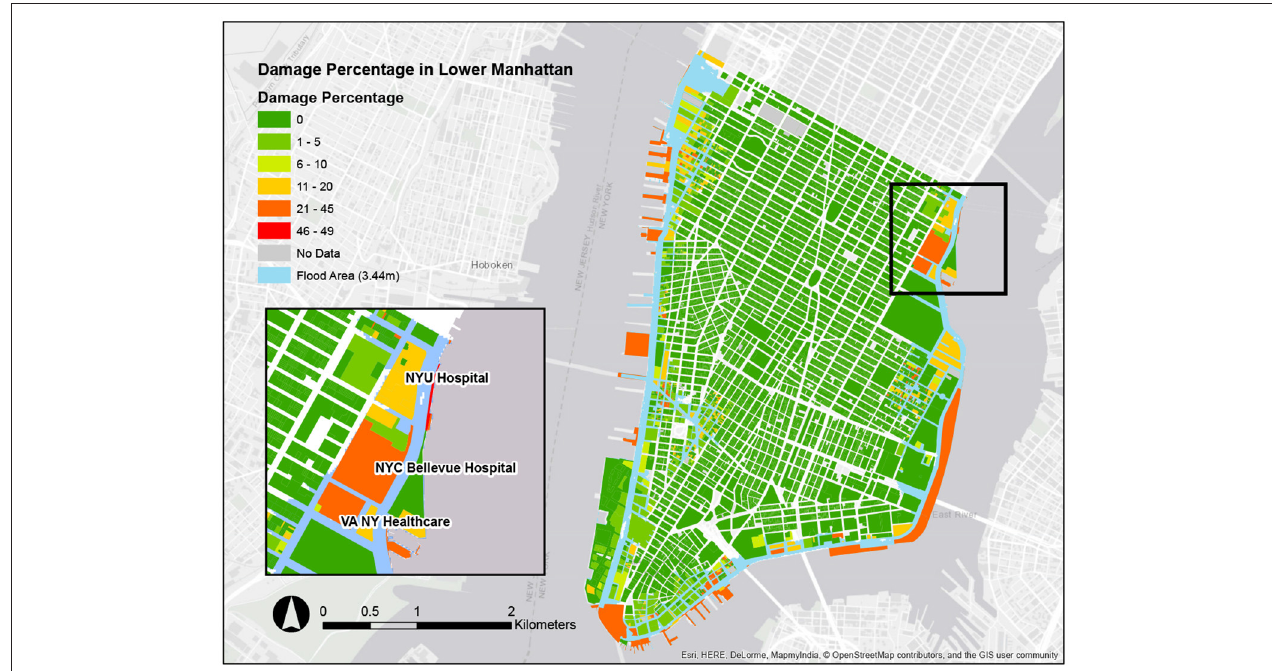
FIGURE 4 | An example of damage percentage calculation for every building/infrastructure component during Hurricane Sandy in Lower Manhattan (Miura et al., 2021c).